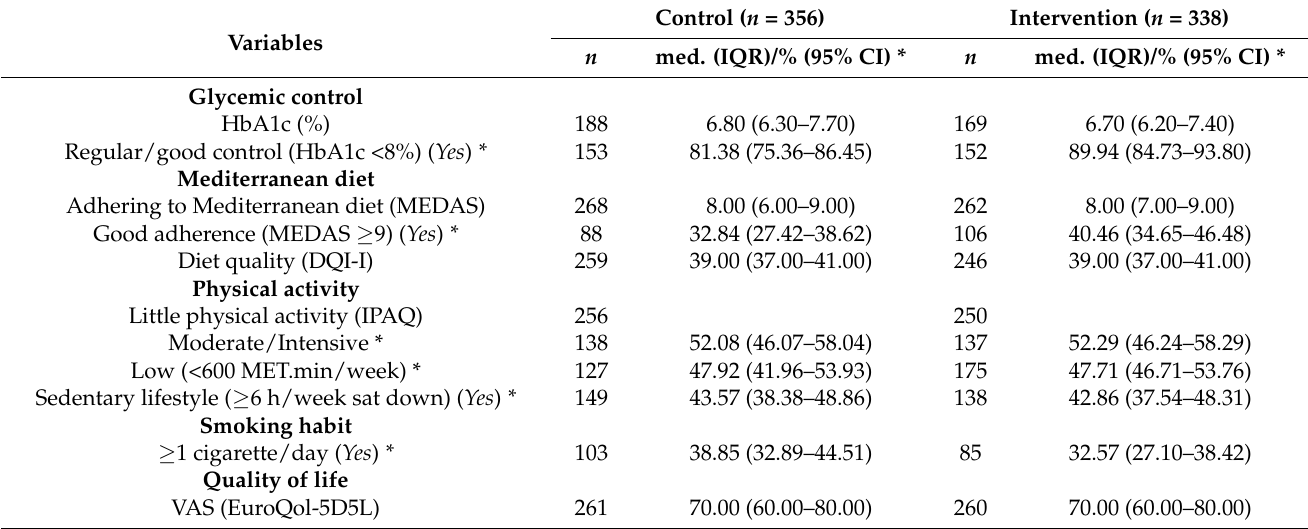
Table 2. Descriptive postintervention analysis of the outcome